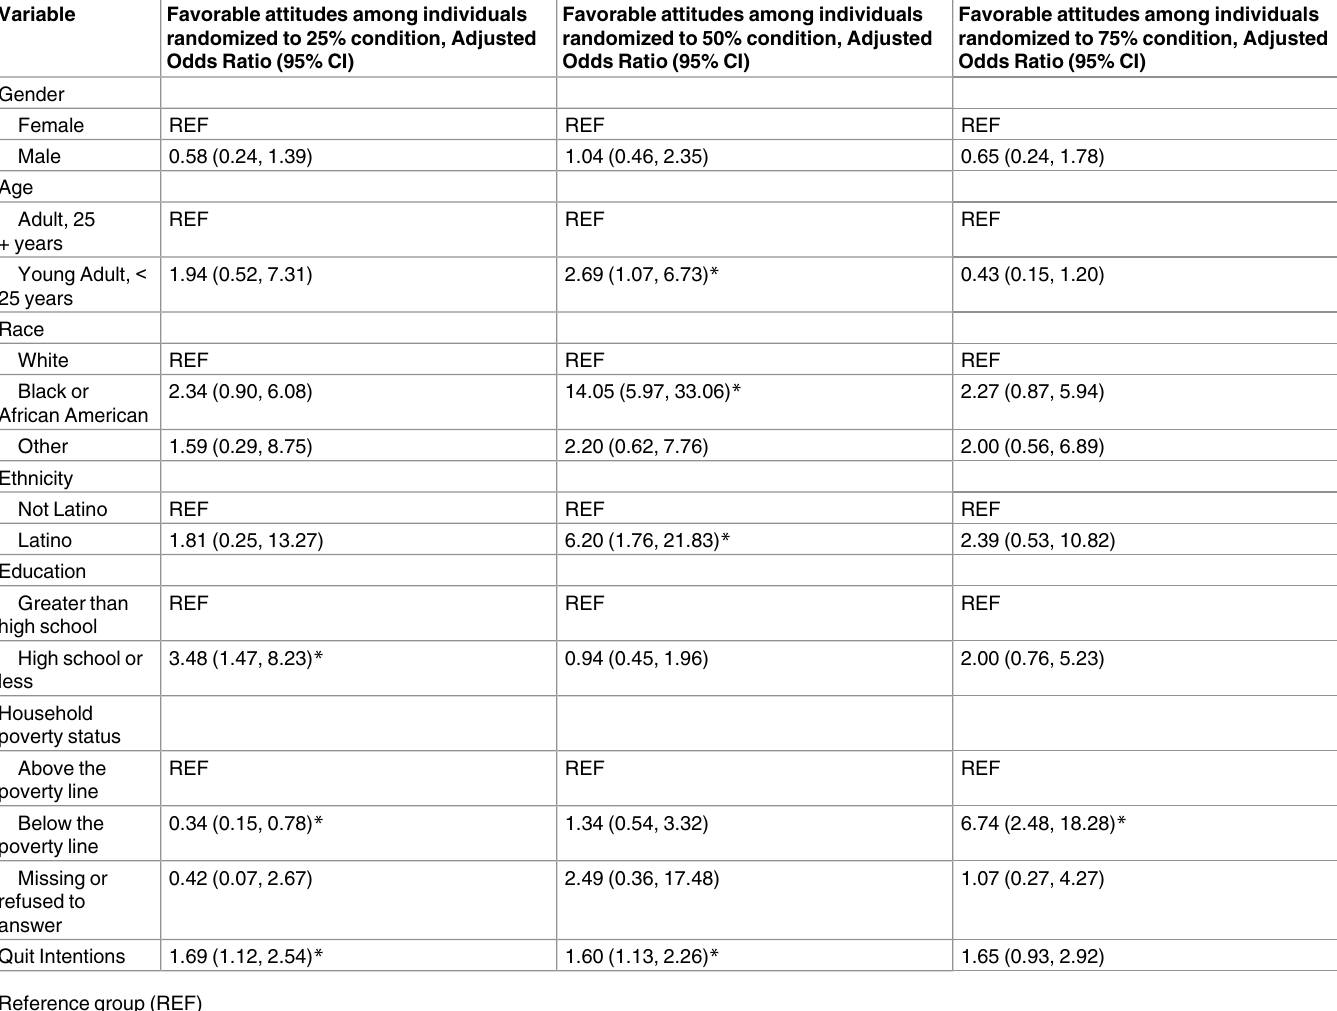
Table 4. Weighted logistic regression results among current smokers,stratified by experimental condition. Variable Favorable attitudes among individuals randomized to 25% condition,